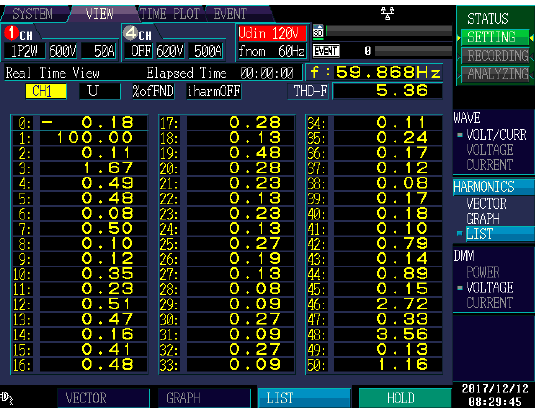
Figure 14. List of Total Harmonic Distortion (THD) value of the CMLI in the ideal case (power supplies of equal value). 5.4. Multilevel Inverter Behavior from the Fault-Free Condition to the Fault Condition (Degraded Response)